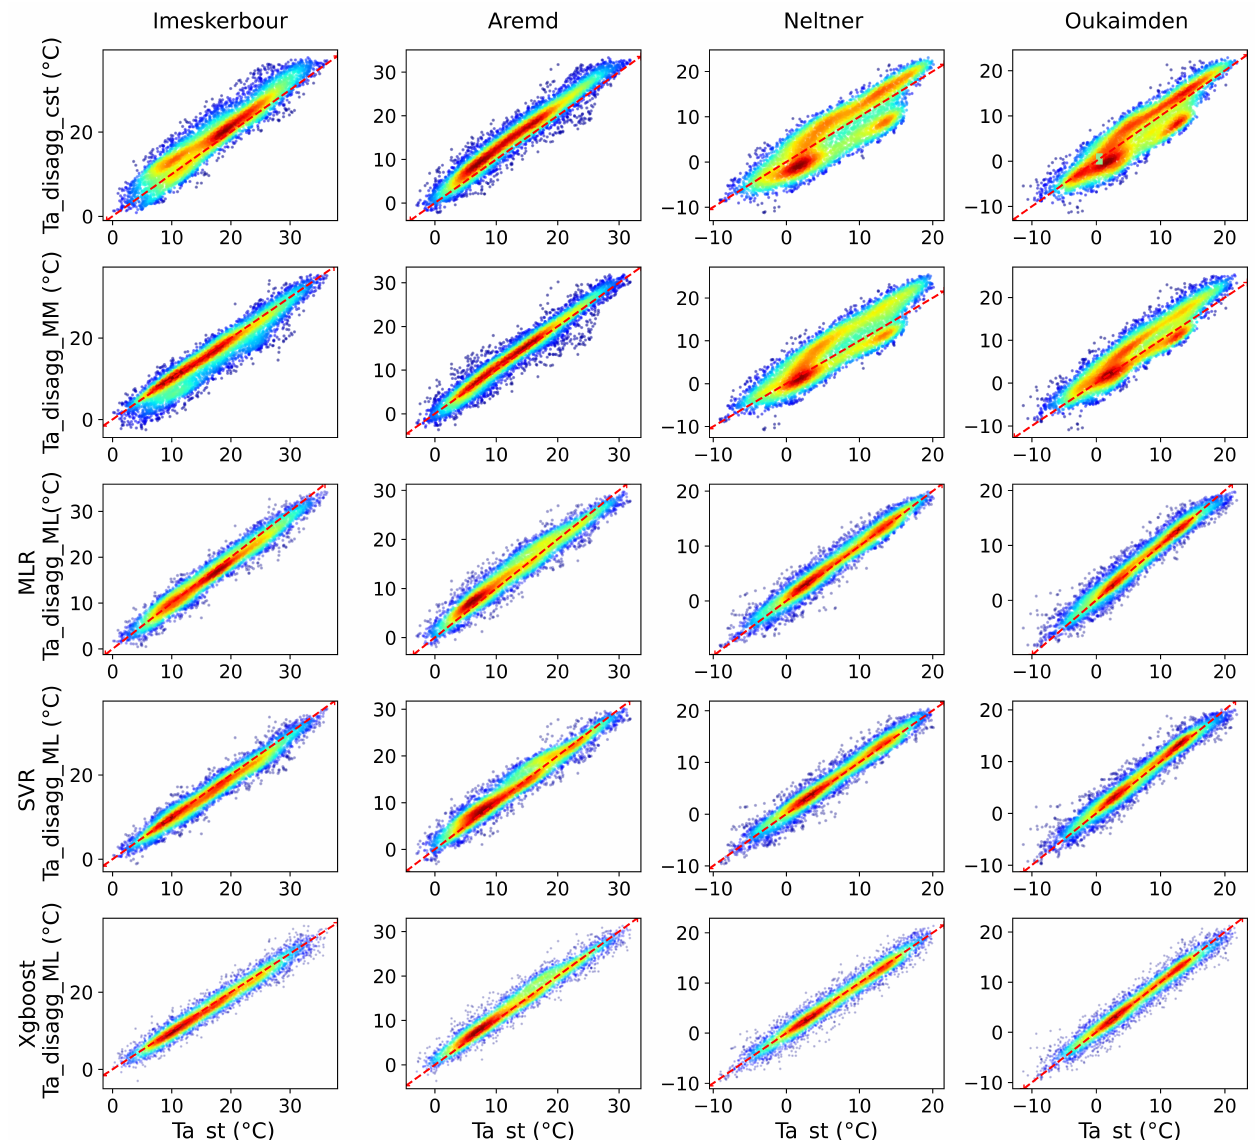
Figure 10. Performance evaluation of machine-learning-based ERA5-Land’s temperature downscal- ing against traditional Methods using In Situ